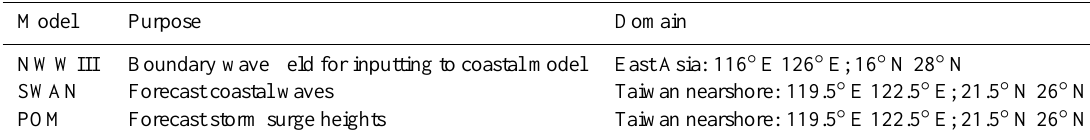
Table 2. Models used in the warning system.